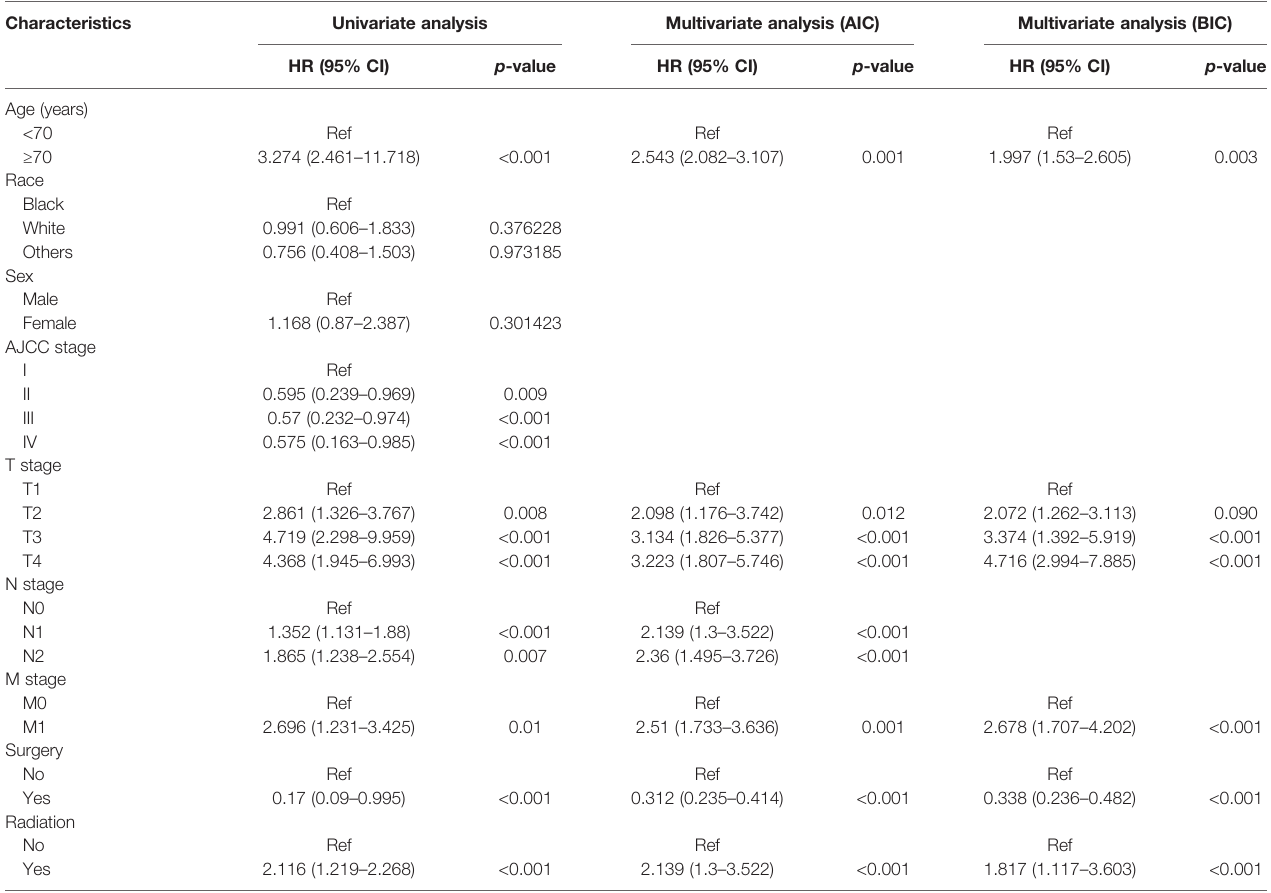
TABLE 3 | Results of univariate and multivariate analyses by Fine-Gray proportional subdistribution hazards model in the training cohort. Characteristics Univariate analysis Multivariate analysis (AIC) Multivariate analysis